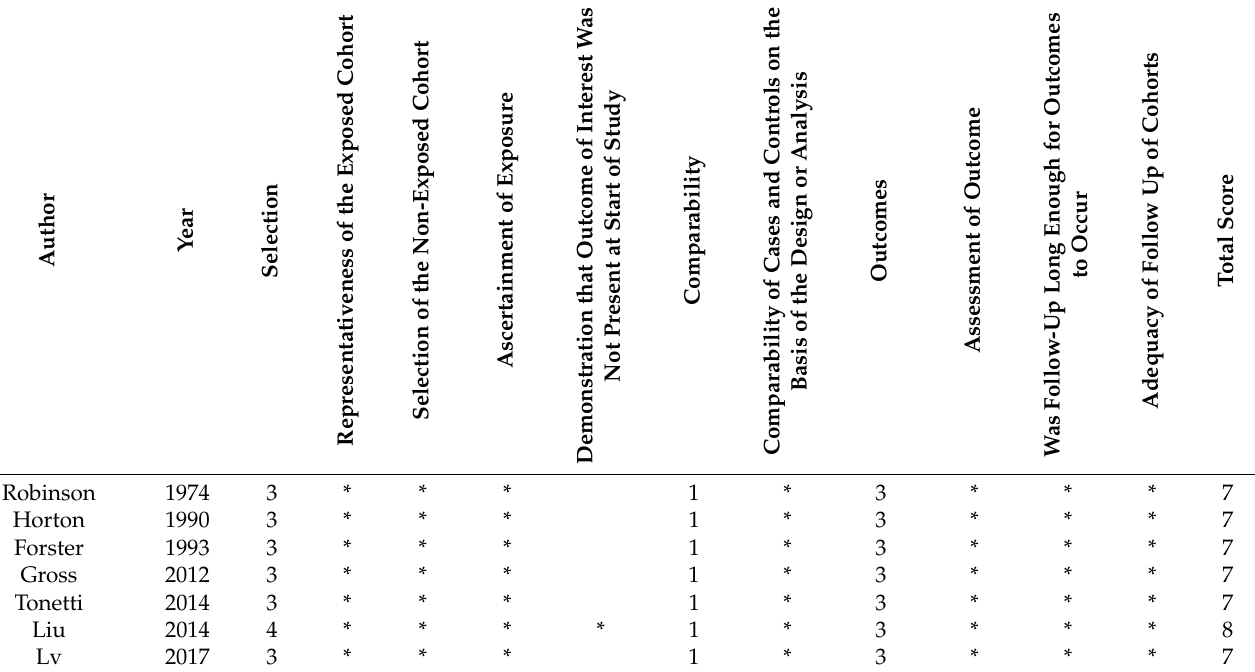
Table 2. Risk of bias assessment by the Newcastle Ottawa Scale of included studies (n =